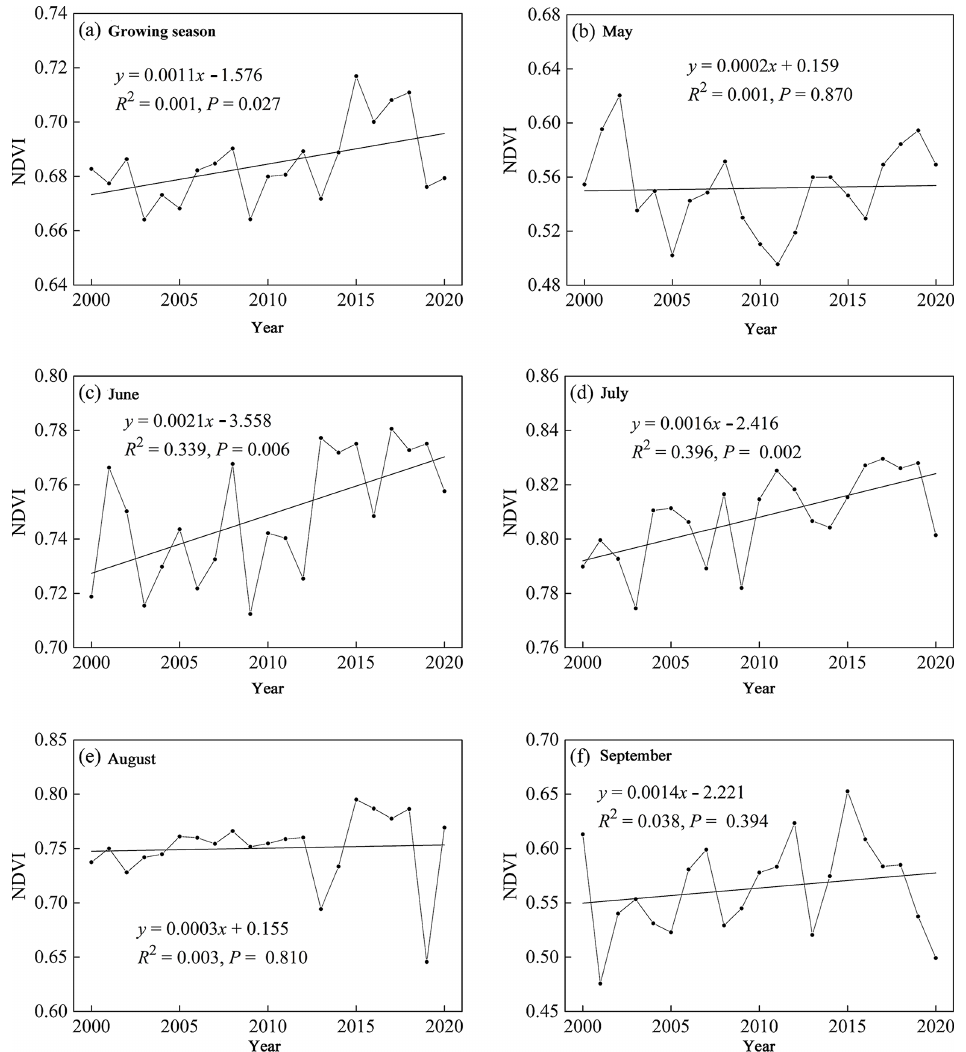
Figure 2. Changes of vegetation NDVI of marshes inSanjiang Plain from 2000 to